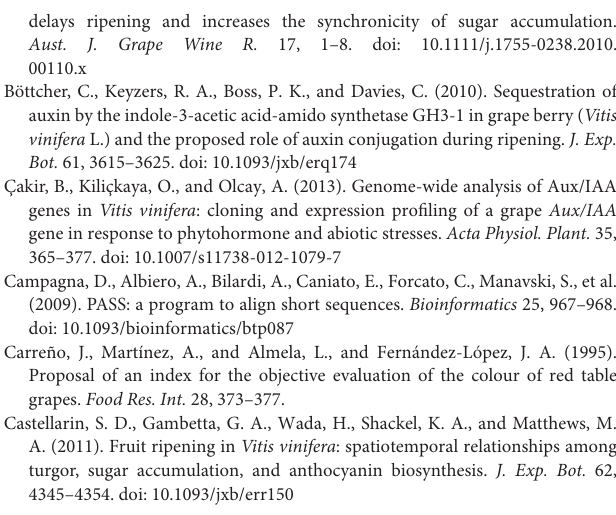
Supplementary Figure S2 | Samplings of berries grown in both 1103P/CS and M4/CS graft combinations were performed at different stages of berry development and ripening. Growing season: 2012. (A) Soluble solids content in CS/M4 (squares) and CS/1103P (circles) throughout fruit development. (B) CIRG values of CS/M4 (square) and CS/1103P (circle) graft combinations throughout fruit development. Bars represent the SD of 100 berries. CS/M4 and CS/1103P data from samples collected at the same DAFB were statistically treated using Student’s t -test ( ∗ P < 0.05 ; ∗∗ P < 0.01 ). Supplementary Figure S3 | Quantitative RT-PCR analyses on the following VviYUC1, VviTAR4, Vvi ARF25, VviIAA15b, VviGH3-21, and VviGH3-22